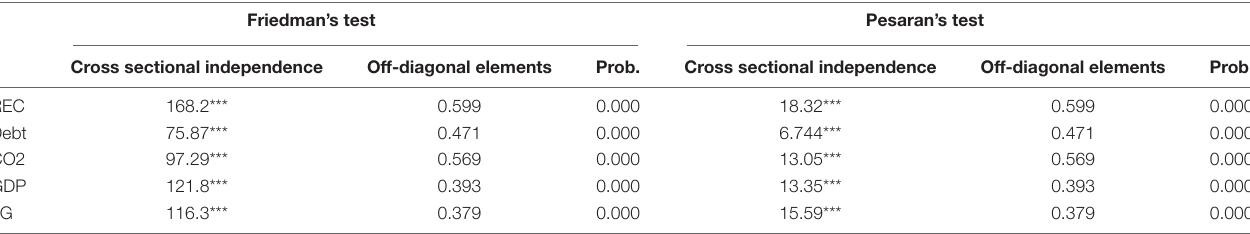
TABLE 2 | Cross-sectional dependence tests.